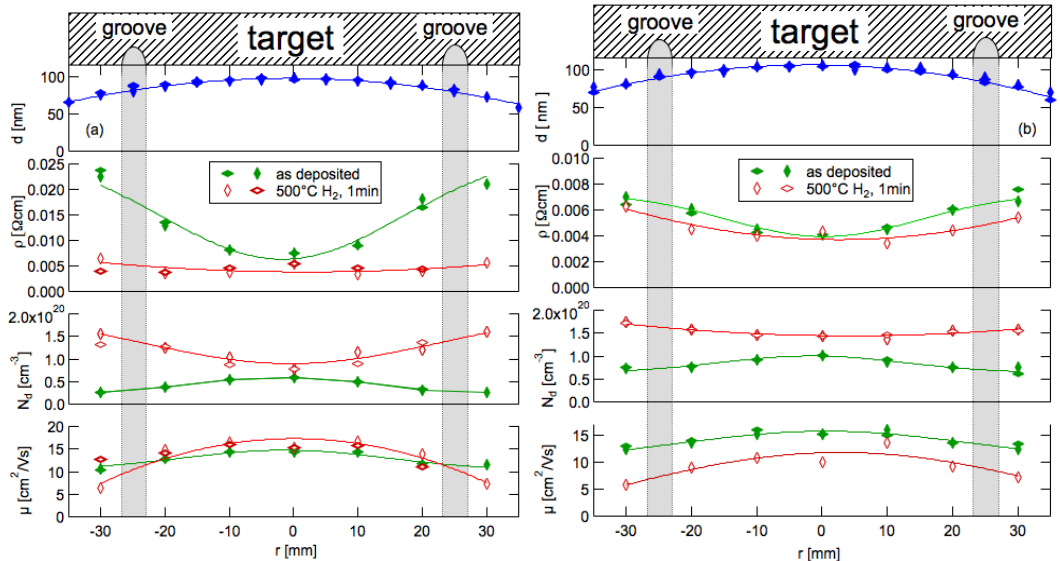
Figure 9. Radial profiles of film thickness, resitivity, carrier concentration and Hall mobility for ( a ) DC plasma excitation (P DC = 15 W, V T = 317V, 0.5Pa, RT, N 2 O, R = 10 nm/min) and ( b ) RF plasma excitation (P RF = 100 W, V T = 92 V, 0.5Pa, RT, N 2 O, R = 17 nm/min.). Vertically and horizontally elongated diamonds mark datapoints measured over two diameters in the substrate plane, perpendicular to each other. The red symbols and curves display the electrical parameters after annealing at 500 °C in H 2 for 1 min. The lines are Gaussian fits to the datapoints.